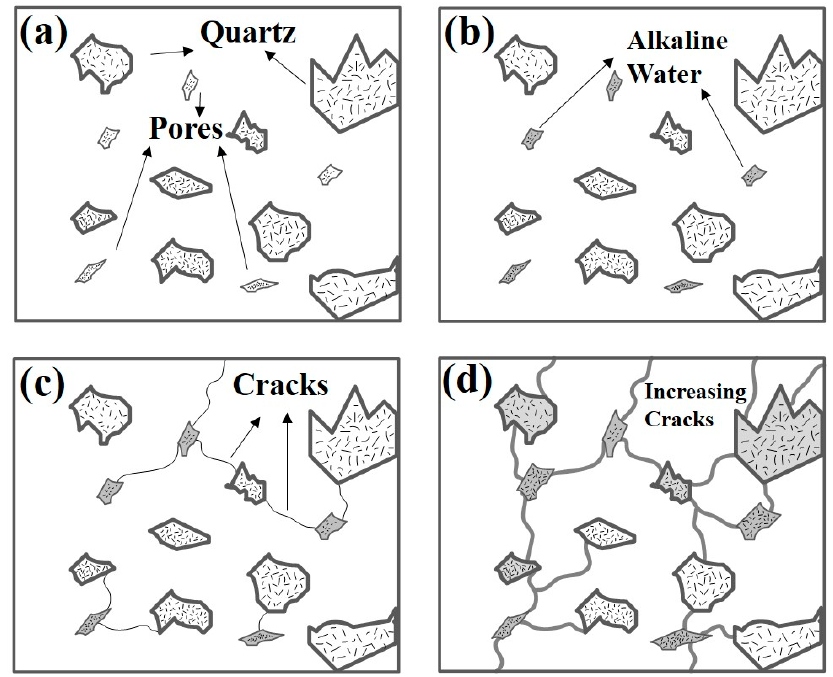
Figure 3. A schematic diagram of the progression of the alkali-silica reaction (ASR) in the cement inside the porcelain insulator ( a ) Stage I, ( b ) Stage II, ( c ) Stage III and ( d ) Stage IV.